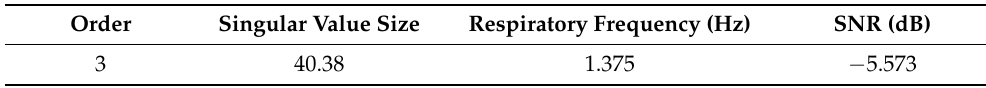
Table 3. Heartbeat signal restoration result.